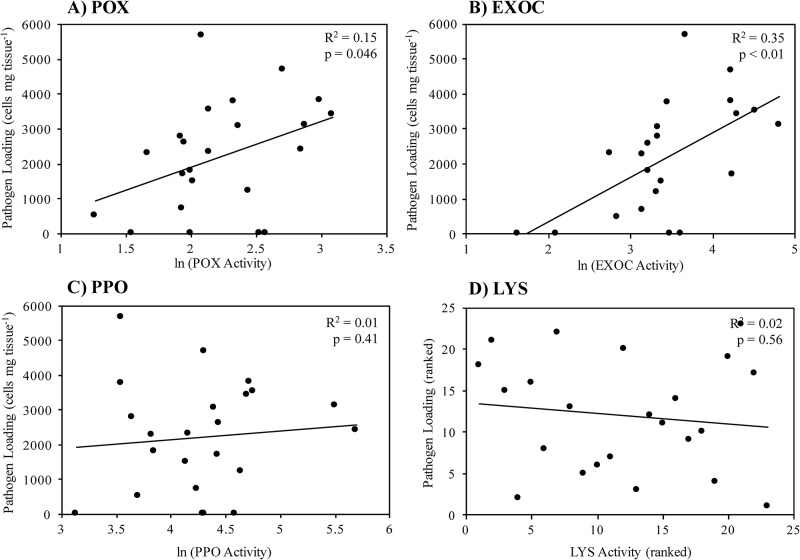
Results of correlation analyses between pathogen load (number of Labyrinthula sp. “E” isolate 8b cells mg tissue-1) and immune biomarker activity (parts A-D: Peroxidase, exochitinase, polyphenol oxidase, and lysozyme, respectively) in T. testudinum individuals from Experiment 2.Significance (p-values) are based on Pearson product-moment correlation coefficients (A-C) or Spearman’s rho correlation coefficients (D). Sample size in parts A, C and D = 24; sample size in part B = 23.